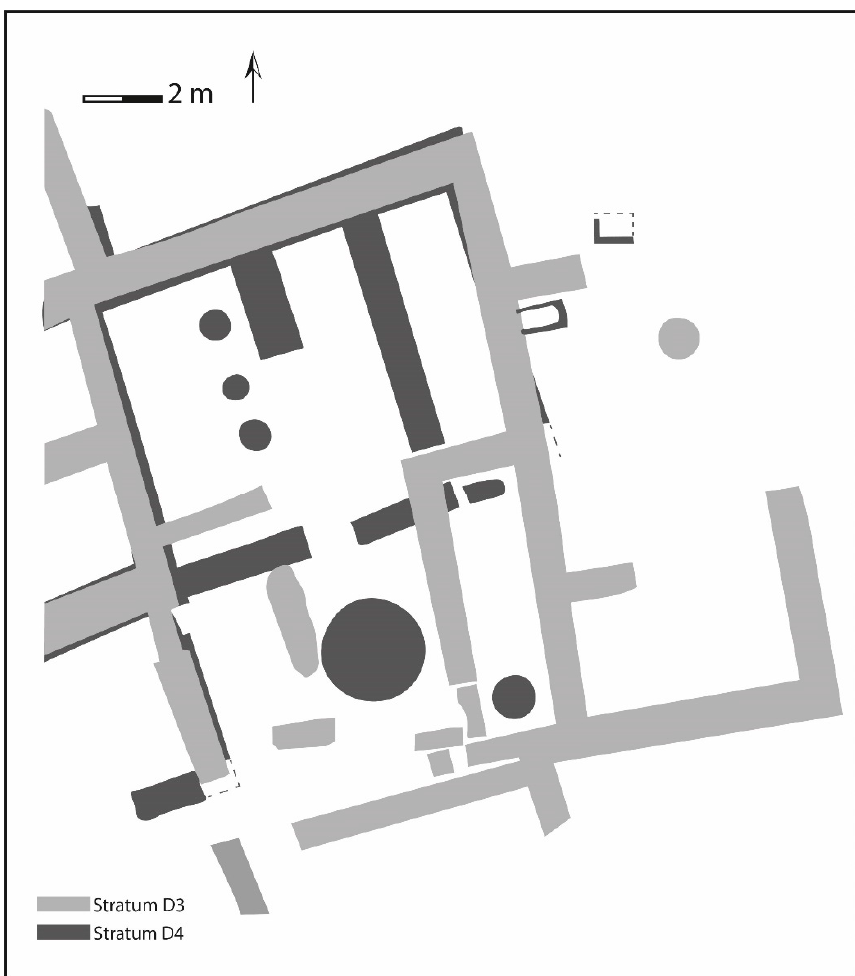
Figure 6. Tell e ṣ - Ṣ afi Area D Temple (after Dagan et al. 2018, Fig.